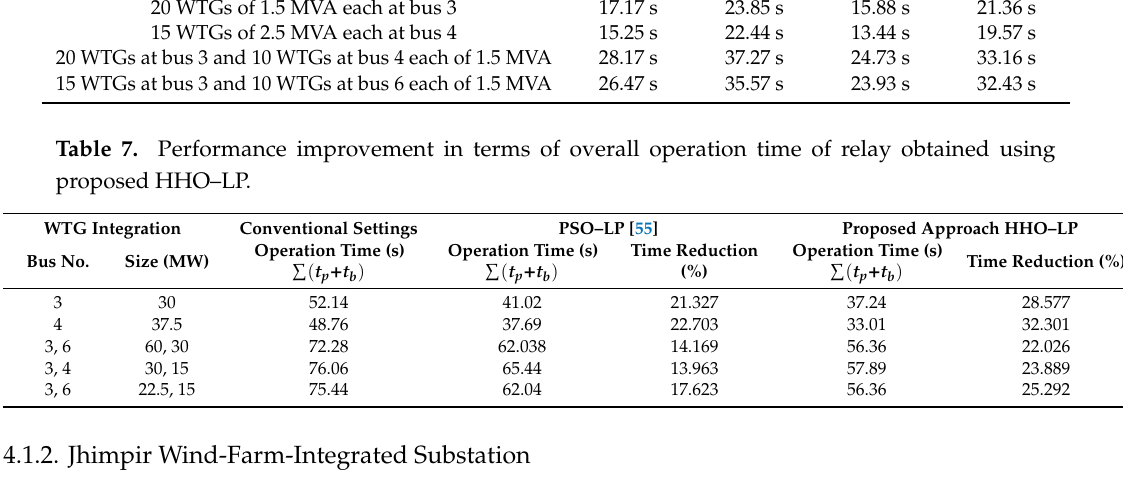
Table 6. Primary and backup relay operation times with variable wind turbine generator (WTG) Table 7. Performance improvement in terms of overall operation time of relay obtained using capacity and location. proposed HHO–LP.